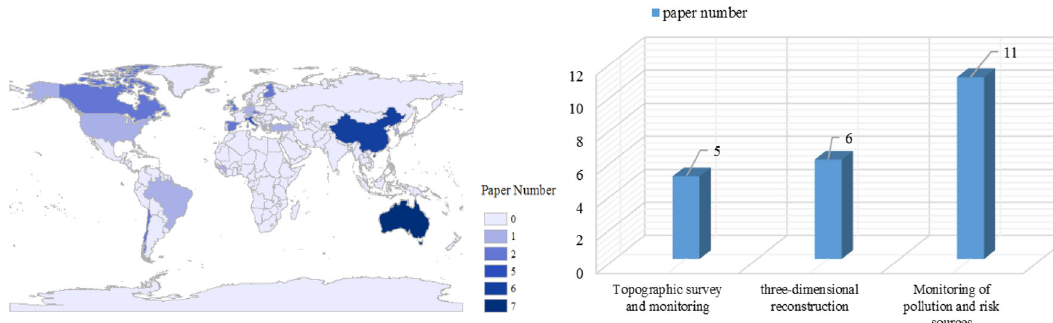
Fig. 1 Analysis of the published papers